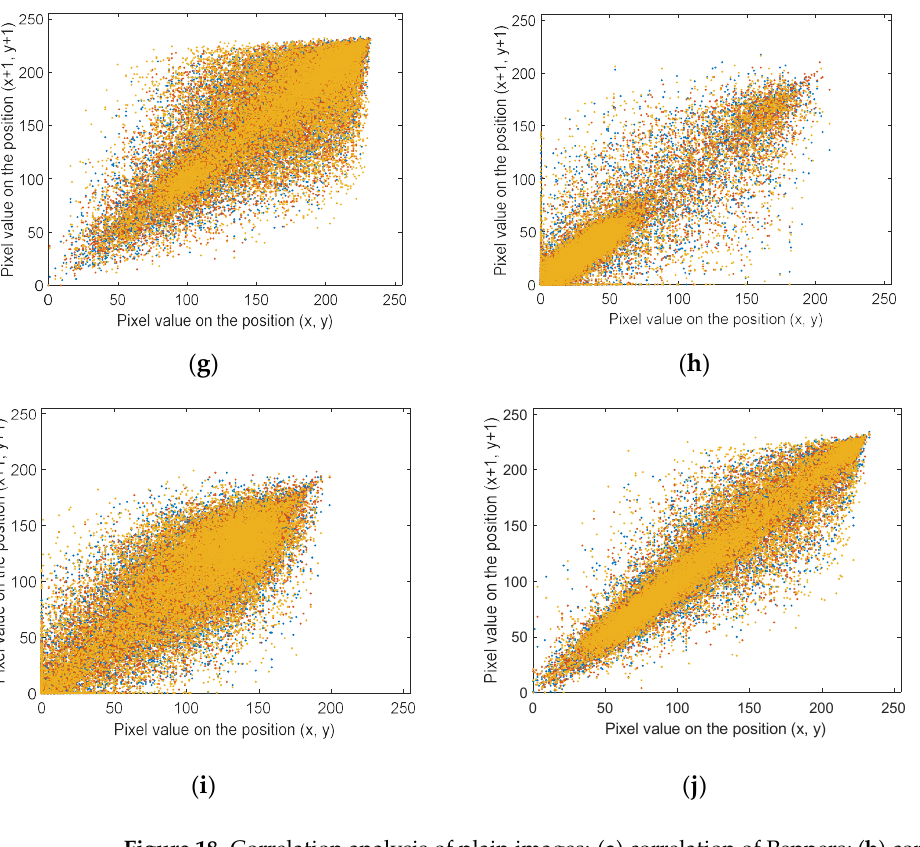
Figure 18. Correlation analysis of plain images: ( a ) correlation of Peppers; ( b ) correlation of Baboon; ( c ) correlation of Airplane; ( d ) correlation of House; ( e ) correlation of Penguin; ( f ) correlation of Sky; ( g ) correlation of Railway; ( h ) correlation of Sea; ( i ) correlation of Water; ( j ) correlation of Building.